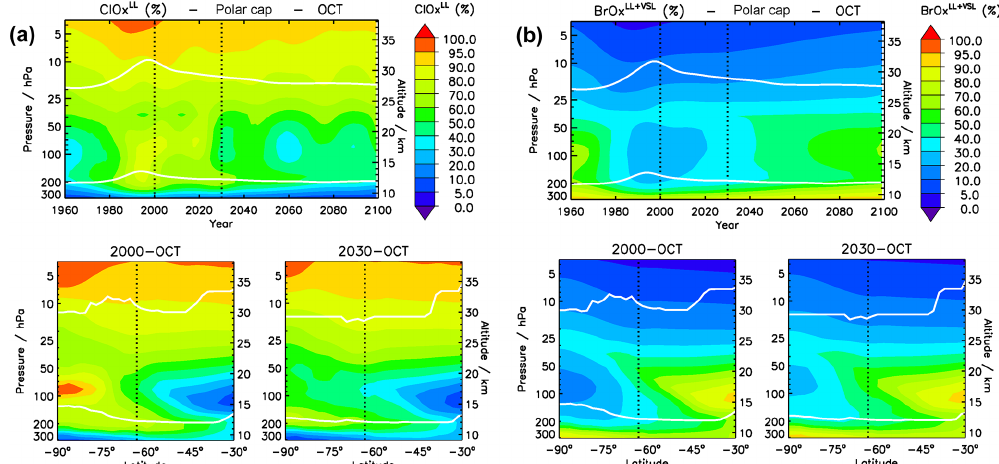
Figure 10. Evolution of the odd-oxygen loss rate vertical profiles (VP) within the southern polar cap. The percentage contribution of each family in respect to the whole halogen loss during October is shown for (a) the ClO LL x family, and (b) the BrO LL + VSL x family. The inset